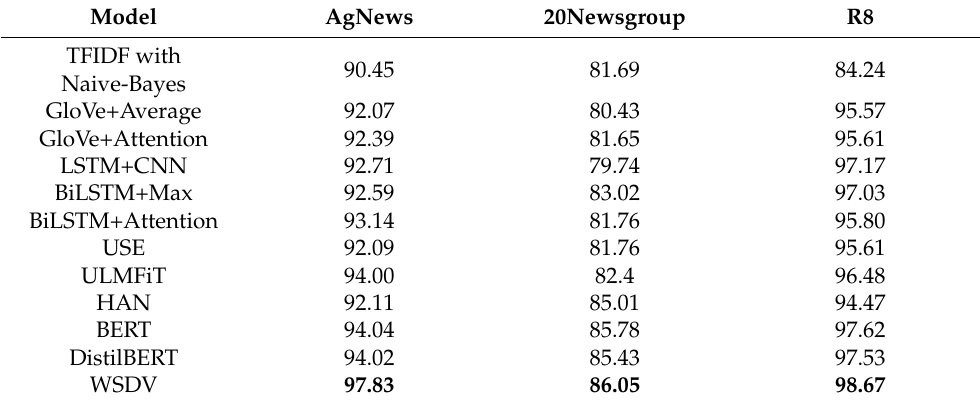
Table 2. Classification accuracy (%) evaluation using different